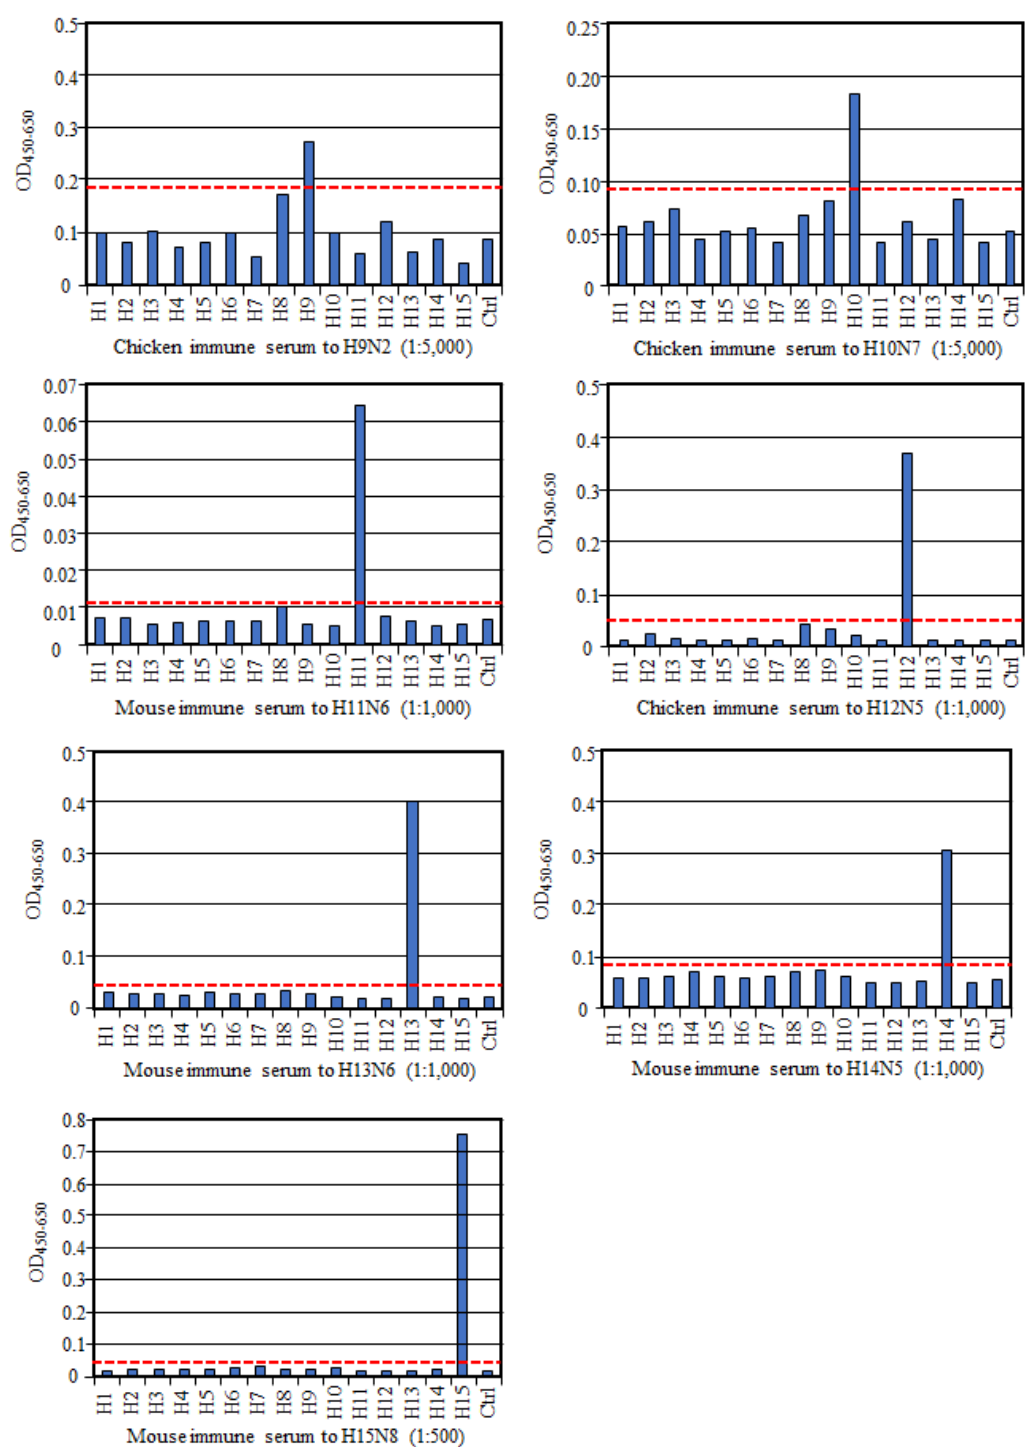
Figure 1. Validation of the multi-hemagglutinin (HA)-ELISA. Specificity of the assay was evaluated using chicken or mouse antisera to each HA subtype. With each antiserum (diluted at 1:500–1:5000), the optical density (OD) 450–650 values to H1–H15 and control antigens are shown. The red dotted line indicates the cut-o ff value, which is the mean OD value plus three times the standard deviation (SD) with the other 15 antigens comprising 14 HA subtypes and a control. Representative results from multiple experiments are shown in the